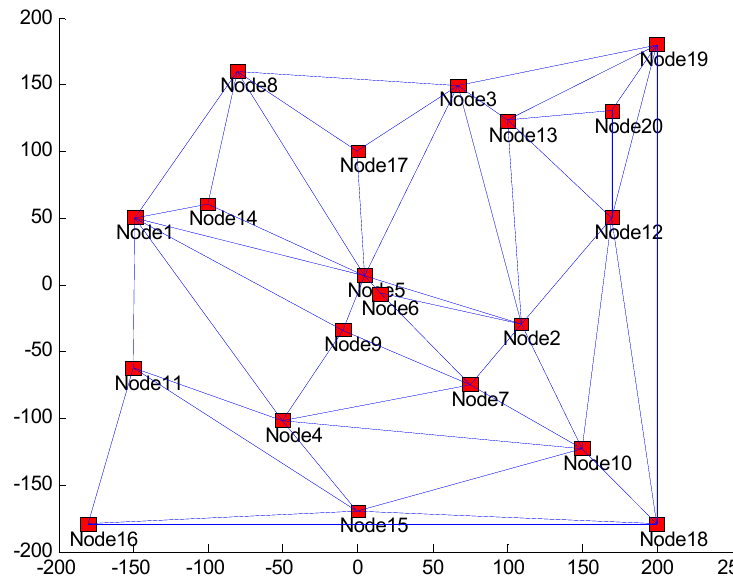
Figure 5. Graph with CONFIG 20-1 configuration (20 nodes).